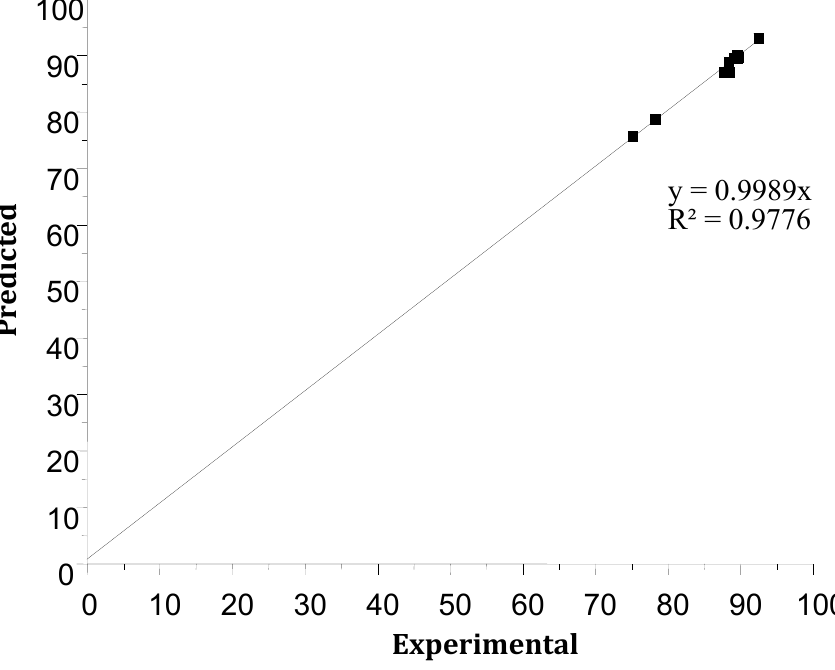
Figure 12. The predicted values of the response versus experimental values.